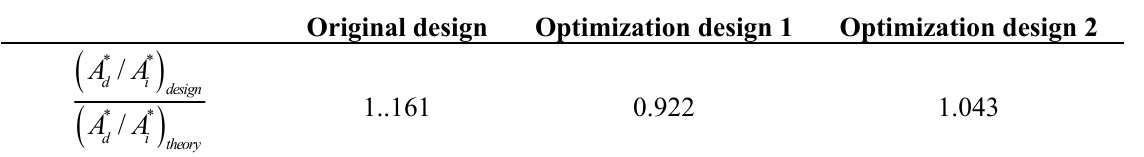
Table 4. Ratio of the impeller and the diffuser throat areas.